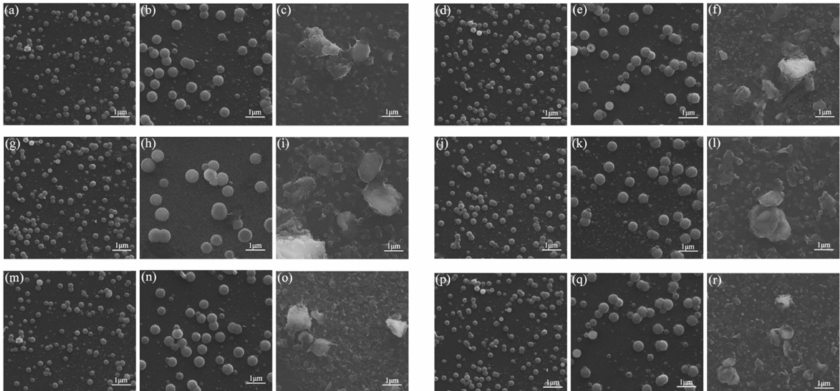
Figure 5. SEM images in CH 3 OH/H 2 O (5:5 v : v ) mixed solutions of compounds ( a ) 1 , ( d ) 2 , ( g ) 3 , ( j ) 4 , ( m ) 5 , ( p ) 6 . SEM images in CH 3 OH/H 2 O (3:7 v : v ) mixed solutions of compounds ( b ) 1 , ( e ) 2 . SEM image in CH 3 OH/H 2 O (2:8 v : v ) mixed solutions of compound ( h ) 3 . SEM images in CH 3 OH/H 2 O (4:6 v : v ) mixed solutions of compounds ( k ) 4 , ( n ) 5 , ( q ) 6 . SEM images in CH 3 OH/H 2 O (1:9 v : v ) mixed solutions of compounds ( c ) 1 , ( f ) 2 , ( i ) 3 , ( l ) 4 , ( o ) 5 , ( r ) 6